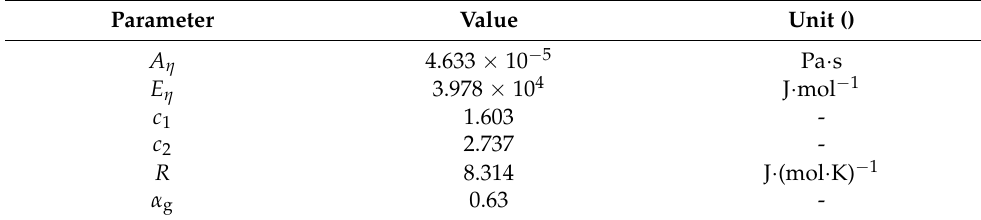
Table 4. Parameters values for the Castro-Macosko viscosity